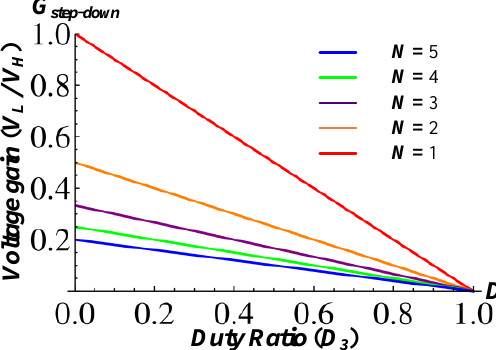
Figure 10. Voltage gain of the proposed topology in the step-down mode.